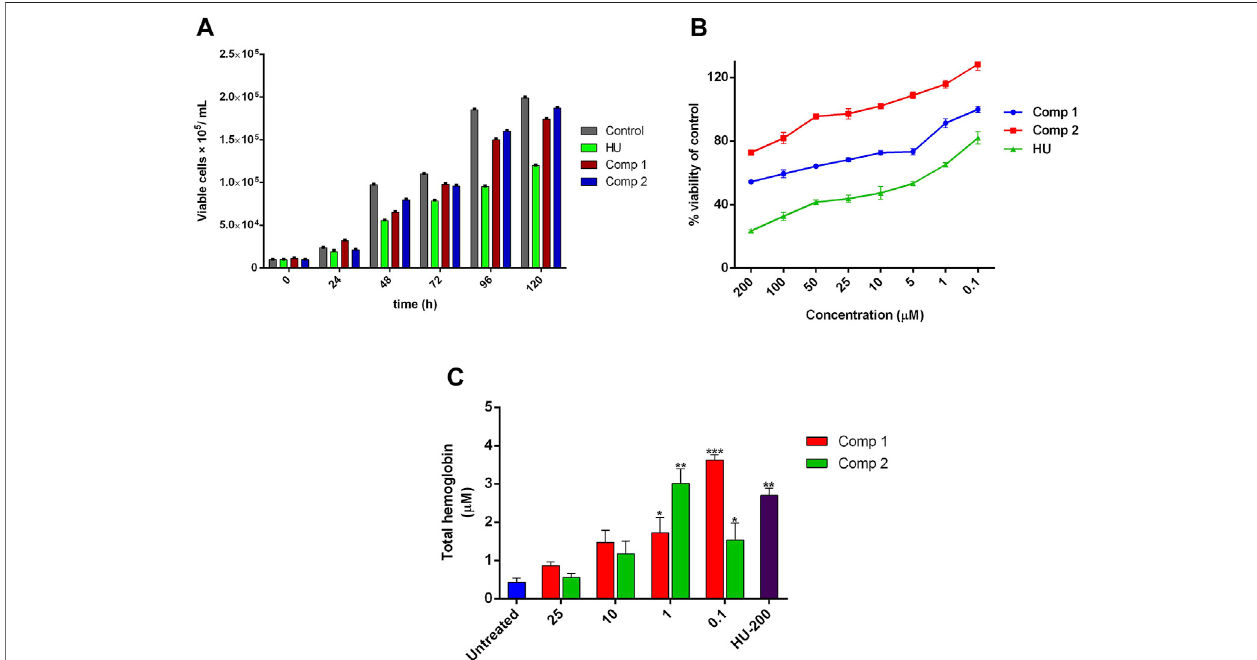
FIGURE5| Effectofleadscompoundsongrowthkinetics,cellviability,andTHbproductioninK562cells. (A) ThetotalnumberofcellspermLofculture.Datawere collected at 24-h point for 1 week, and viable cells were counted using trypan blue dye. (B) Cytotoxic evaluation of compounds in a dose-dependent manner was monitored by alamarBlue assay. (C) The effects of lead compounds on THb accumulation. The results are the average of three independent experiments and represented as mean ± SEM. * p < 0.05 was considered statistically signi fi cant when compared to untreated